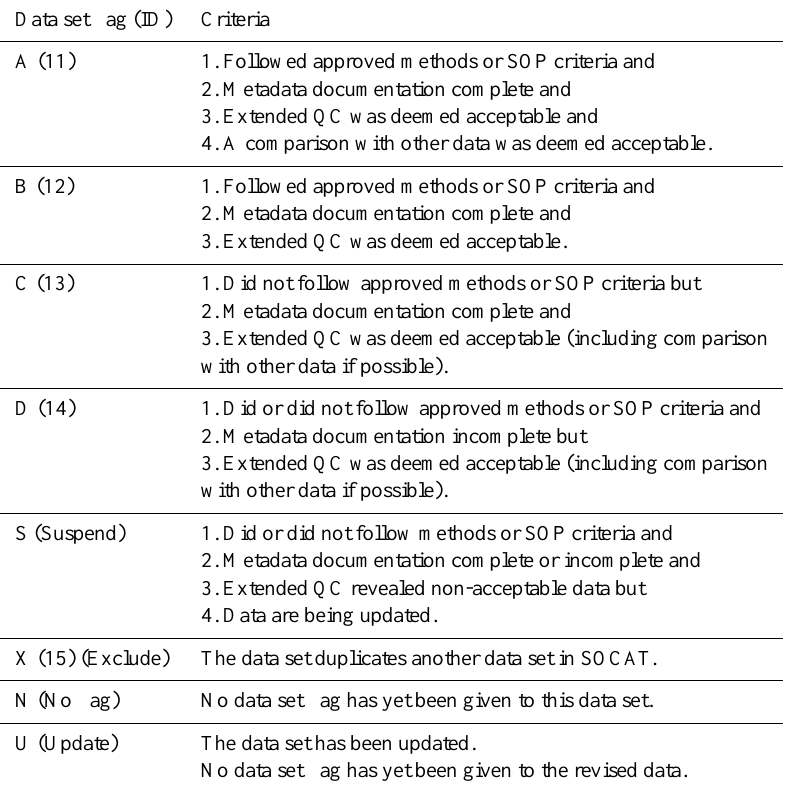
Table 9. Criteria for assigning data set quality control flags based on the expected quality of the recommended f CO 2 values (per Table 6 in Pfeil et al., 2013). All criteria need to be met for assigning a data set flag. Only data sets with a quality control flag of A, B, C and D are included in version 1 and 2 data products. SOP is Standard Operating Procedures (Dickson et al., 2007); QC is quality